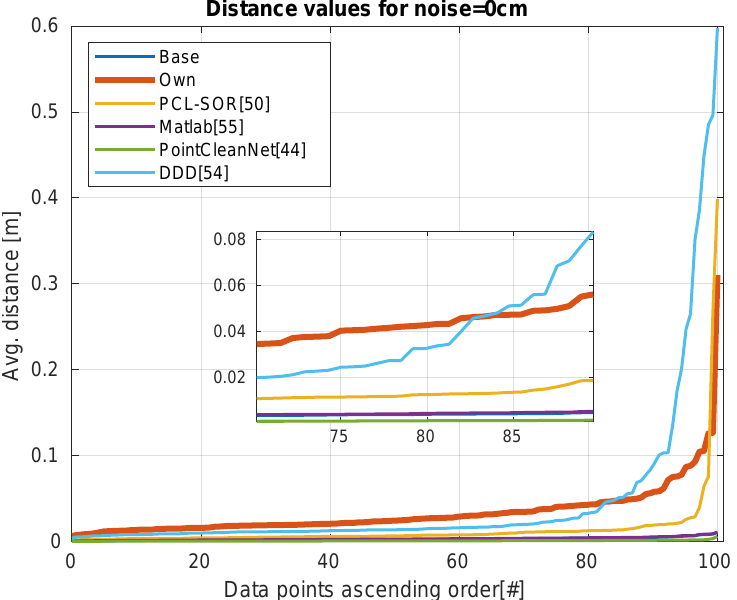
Figure 9. Without additional noise, just the raw data. The distribution of errors over the dataset.